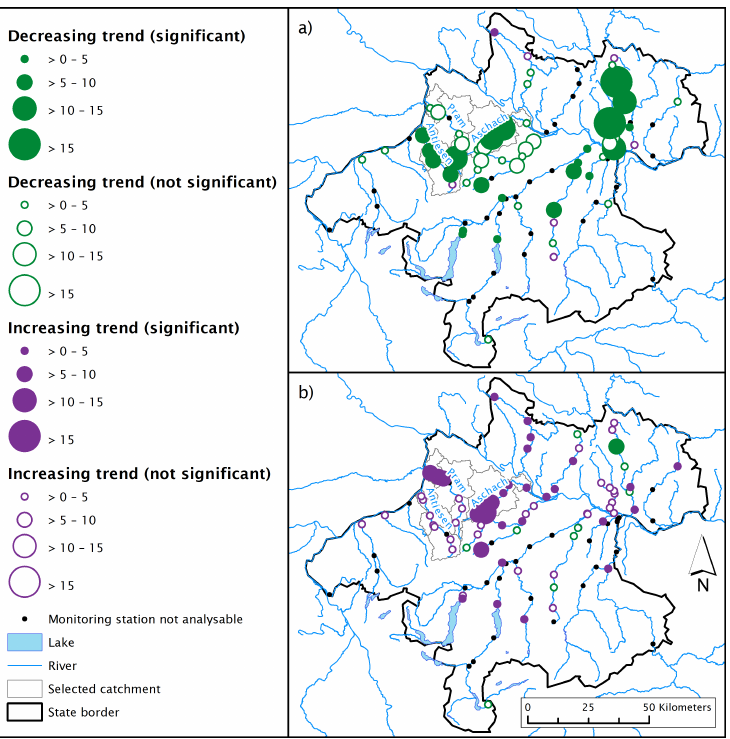
Figure 1. Trends of total phosphorus concentration (µg TP L − 1 year − 1 ) in surface waters in Upper Austria for the following two periods: ( a ) 1990–2000; ( b ) 2001–2014.